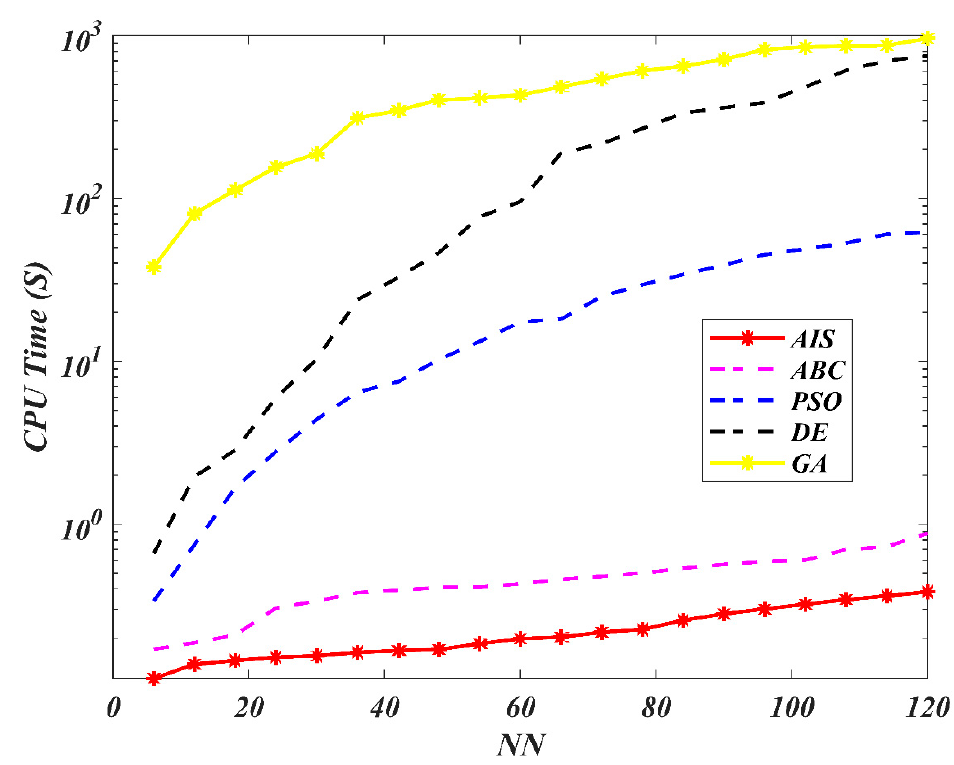
Figure 26. CPU time Evaluation for Car Evaluation.